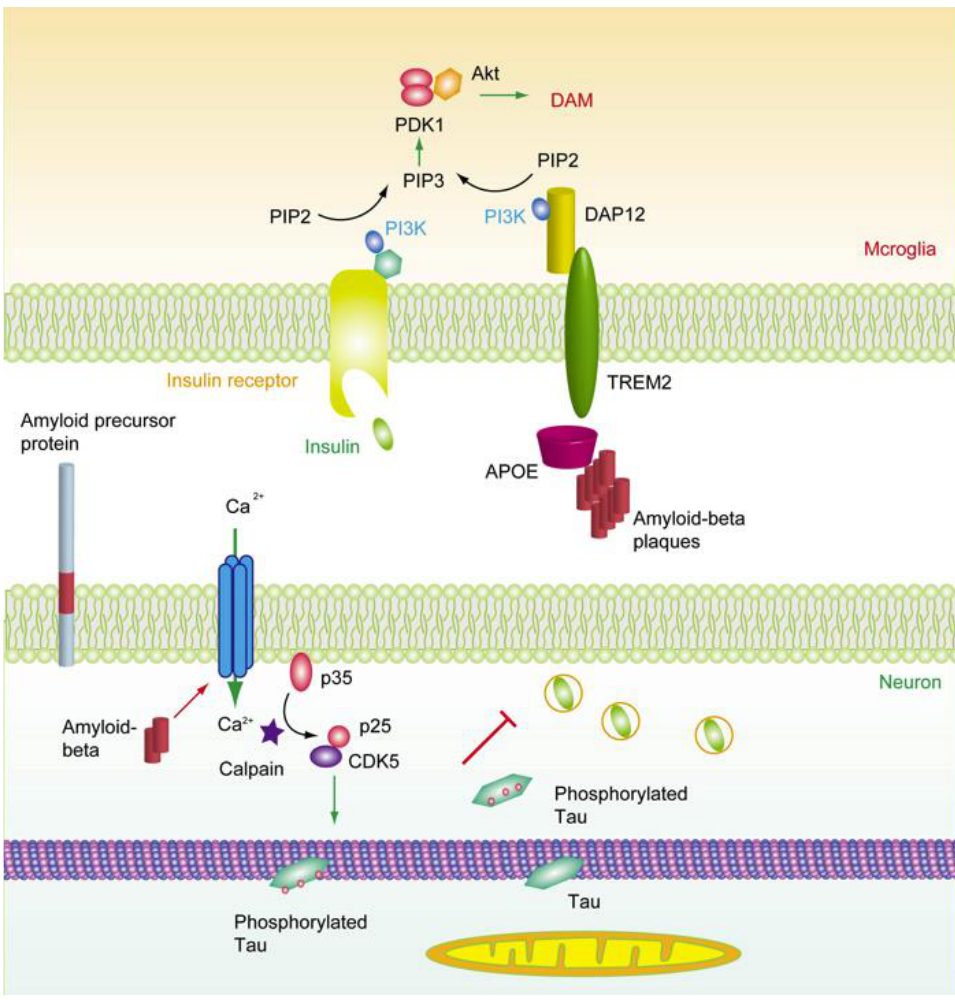
Figure 2. The deductive role of insulin signaling in AD pathology. Aβ induced calcium influx and the activation of calpain, which further triggered the activation of CDK5 through the cleavage of p35 [31]. CDK5 induced phosphorylation of tau, triggered the detachment of tau from microtubules, and in turn perturbed the function of mitochondria. On the other hand, the microglia switch homeostasis to DAM status in an APOE- and TREM2-dependent manner to protect neurons from the damaging effect of Aβ overproduction [32,33]. TREM2 functions via its adaptor DAP12 (DNAX activation protein of 12 kDa) and PI3K-Akt pathway, which is also regulated by insulin signaling. Thus, insulin can inhibit tau phosphorylation by suppressing GSK3β in neurons and help microglia to maintain the proper DAM status via PI3K-Akt pathway.